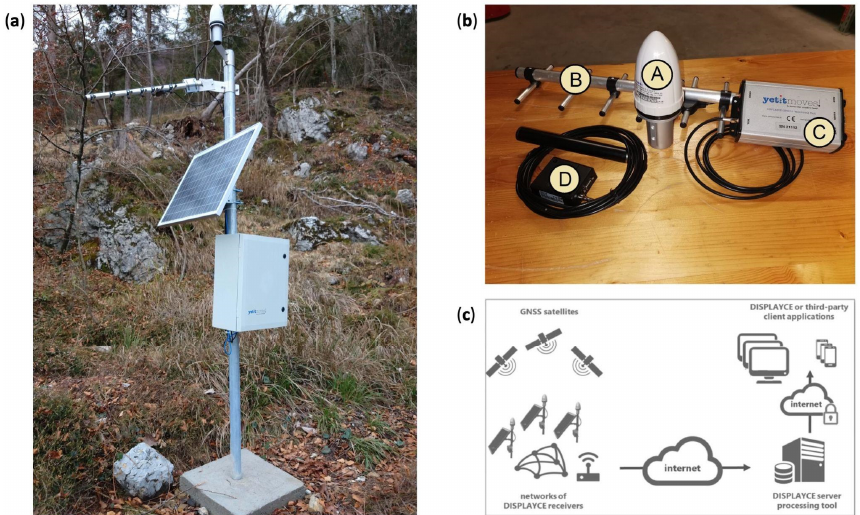
Figure 2. ( a ) One monumentation column anchored to the ground with DISPLAYCE instrumenta- tion, with the solar panel and the electric box (GPS9 in this photo). The column, designed to be integral with the terrain, is made of a galvanized pipe anchored to the ground through a cemented foundation; ( b ) Instrumentation components of each station: 1 GPS antenna (A); 1 Yagi antenna for data transmission on 868 MHz (B); 1 box containing the single-frequency GPS receiver UBLOX NEO M8T, the 868 MHz radio transmission system, and the voltage regulator for the batteries and the solar panel (C); and 1 GPRS Telit modem in the case that the station works as a gateway, with the antenna (D); ( c ) Scheme of the presented monitoring system (image modified from the Displayce